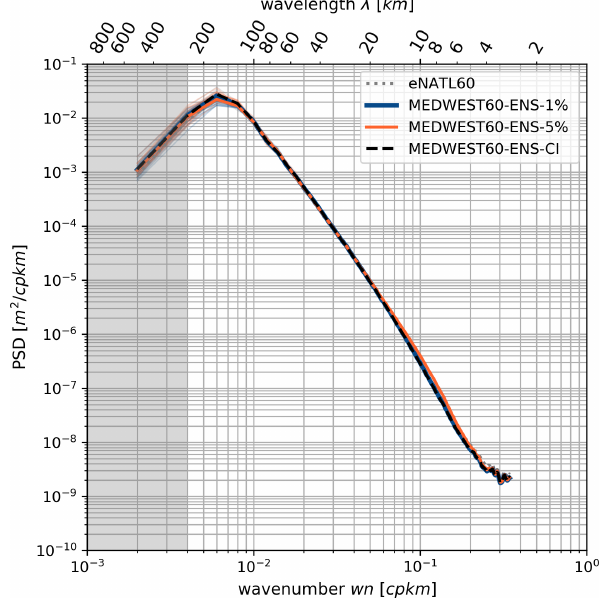
Figure 4. Wavenumber spectrum (power spectral density, PSD) of hourly SSH snapshots in the MEDWEST60 ensemble experiments, in a box of 350 × 350 grid points (see box a in Fig. 1), corre- sponding to a size L ∼ 490km. Comparison is also made with the eNATL60 simulation. The PSD of SSH [m 2 cpkm − 1 (cpkm – cy- cle per kilometer)] is averaged in time over 241 hourly snapshots of SSH, 1 hourly spectrum every 6h, over the 2 months of simulation and over all members of the given ensemble (thick lines). The PSDs of all individual members are also shown as thin lines, in the same color as their ensemble mean. The gray shading indicates where the spatial scales are not fully resolved within the considered region (scales larger than L/ 2 ∼ 250km).